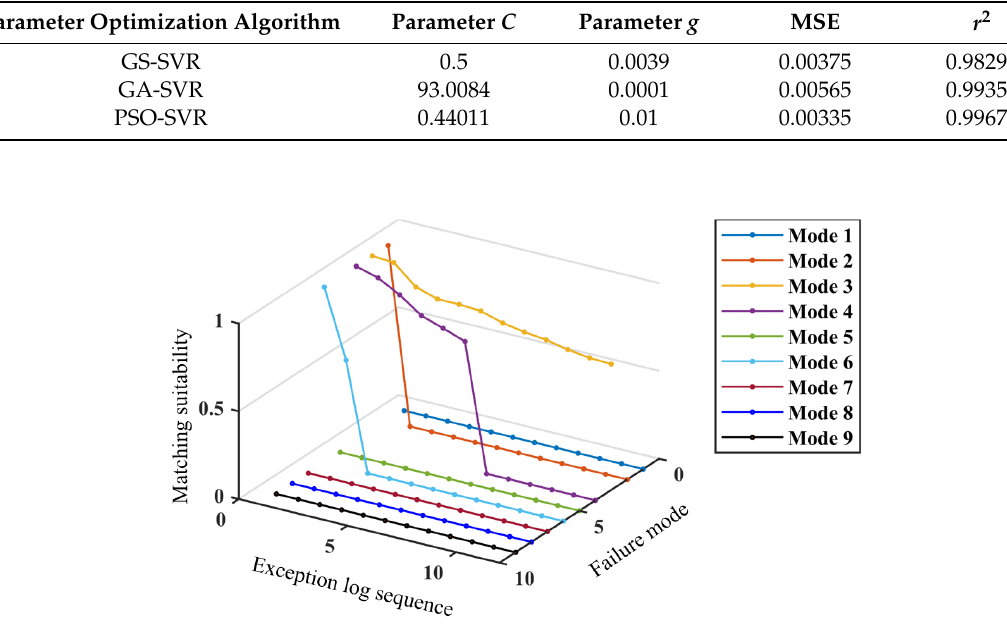
Figure 11. Example of a failure mode matching process.